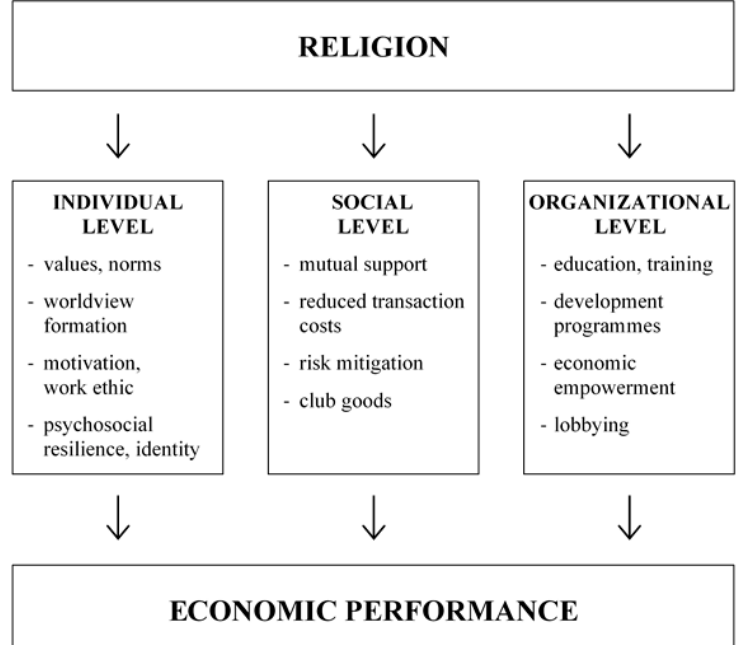
Figure 1. Transmission mechanisms from religion to economic outcomes. Note—Author’s elaboration based on Haynes (2009) and Öhlmann et al. (2016). While the separation of the three dimensions is a useful analytical tool, it should be noted that the three dimensions are intertwined in practice and in the self-understanding of most religious communities.